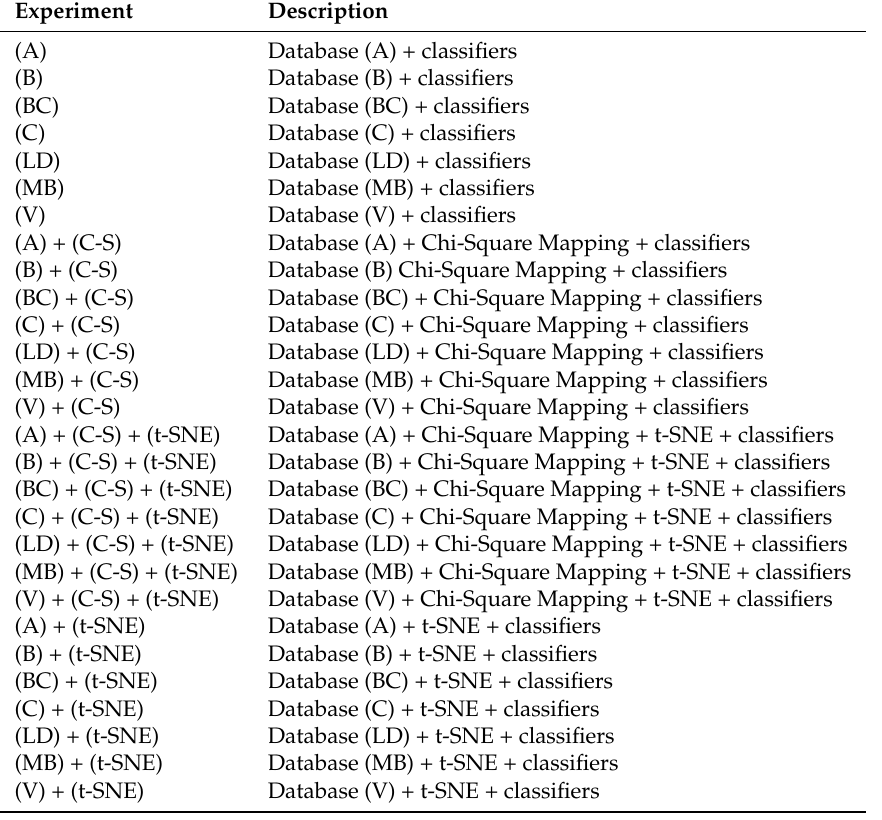
Table 2. Description of experimental